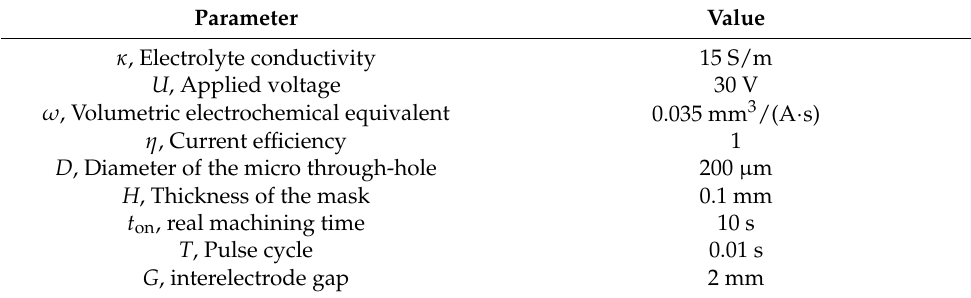
Table 1. The parameters for the